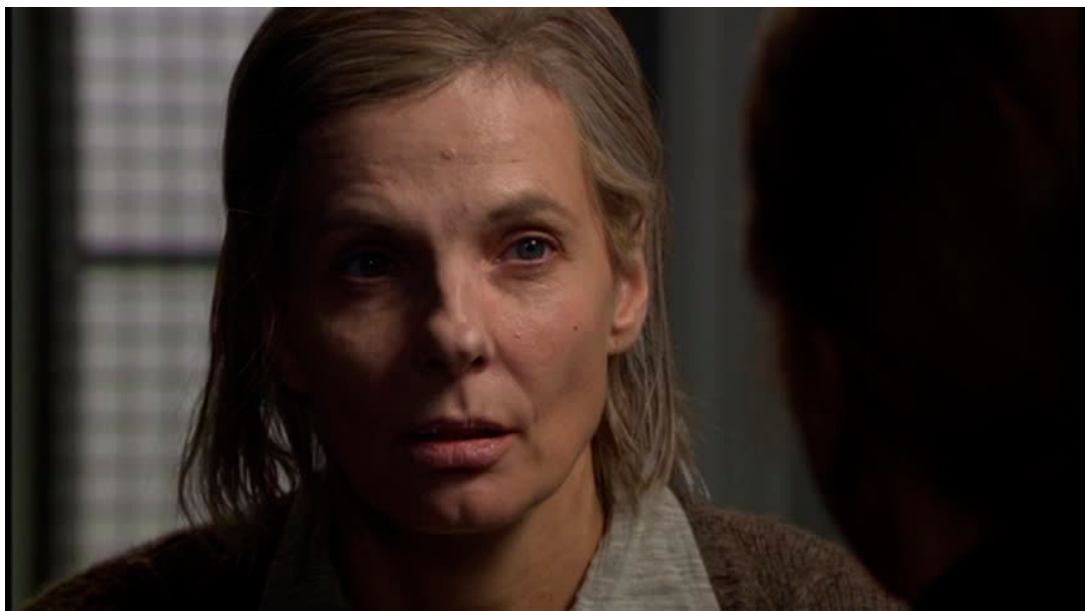
Figure 24. Silence, Touch, Communion.